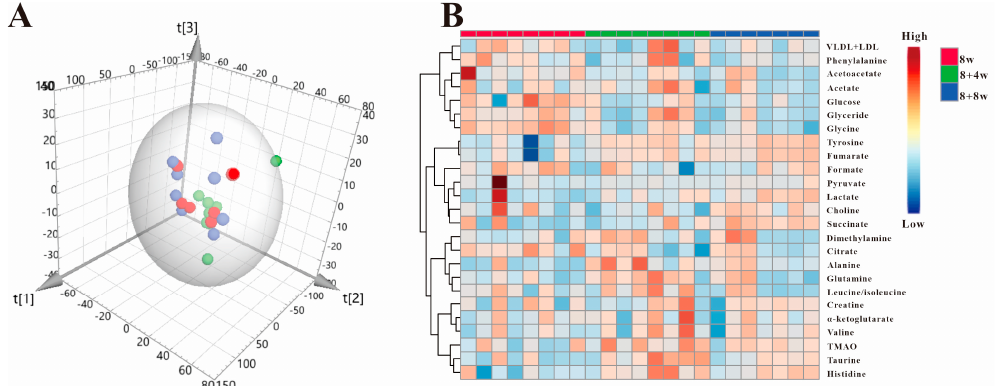
Figure 8. ( A ) PCA scores plots for 1 H-NMR spectra data of SAP − / − mice serum. ● 8 w; ● 8 + 4 w; ● 8 + 8 w; R 2 X = 0.975, Q 2 = 0.816. ( B ) Heatmap of SAP − / − mice in three periods.